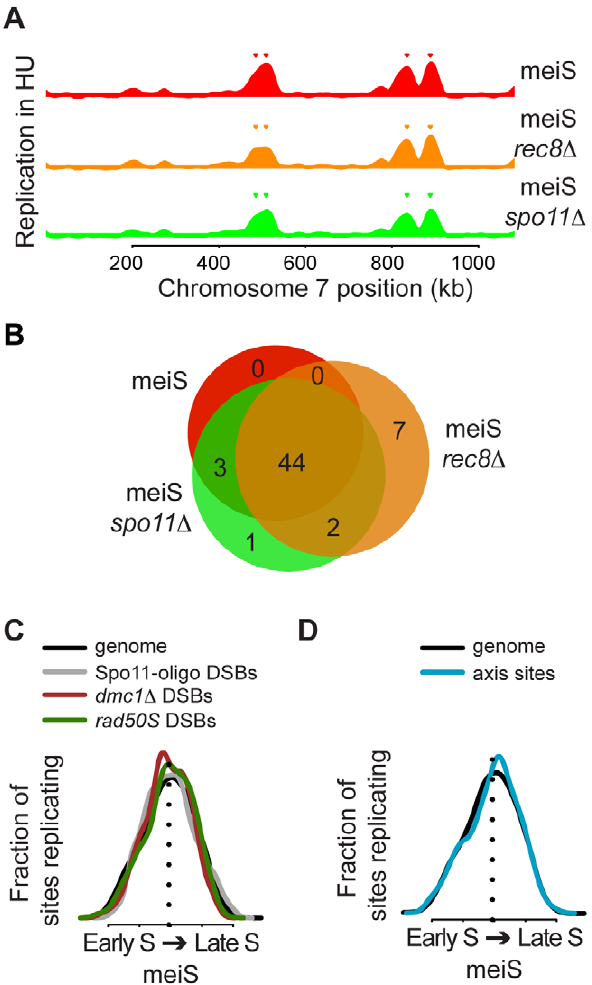
Figure 5. No relationship between DNA replication timing and recombination sites. (A) Chromosome VII replication profiles for pre- meiotic cells in the presence of 20 mM HU are shown for wild-type (H574, red), rec8 D (H5187, orange) and spo11 D (H5184, green) cells. Inverted triangles indicate the position of origins that are considered replicated in each strain. (B) Venn diagram summary of the experiment shown in (A), with the same color coding. (C) The distributions of replication timing in meiS are shown for the entire genome (black line), DSBs hotspots mapped by Spo11-oligo recovery (gray line), ssDNA enrichment in a dmc1 D strain (brown line) and Spo11 binding in rad50S cells (green line). (D) The distributions of replication timing in meiS are shown for the entire genome (black line) and for axis association sites (blue line).